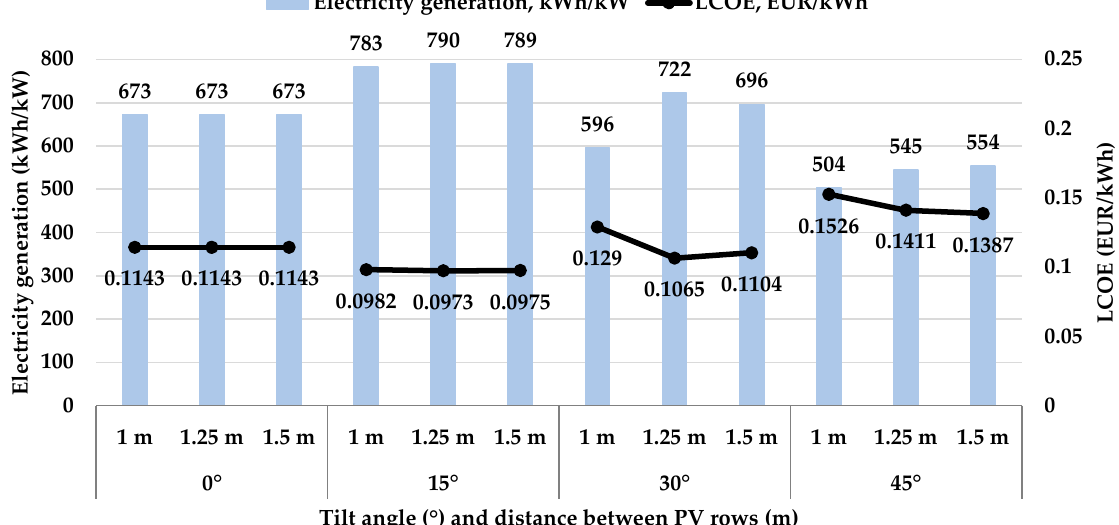
Figure 2. Relative electricity generation per year and LCOE at different tilt angles and distances between PV rows.